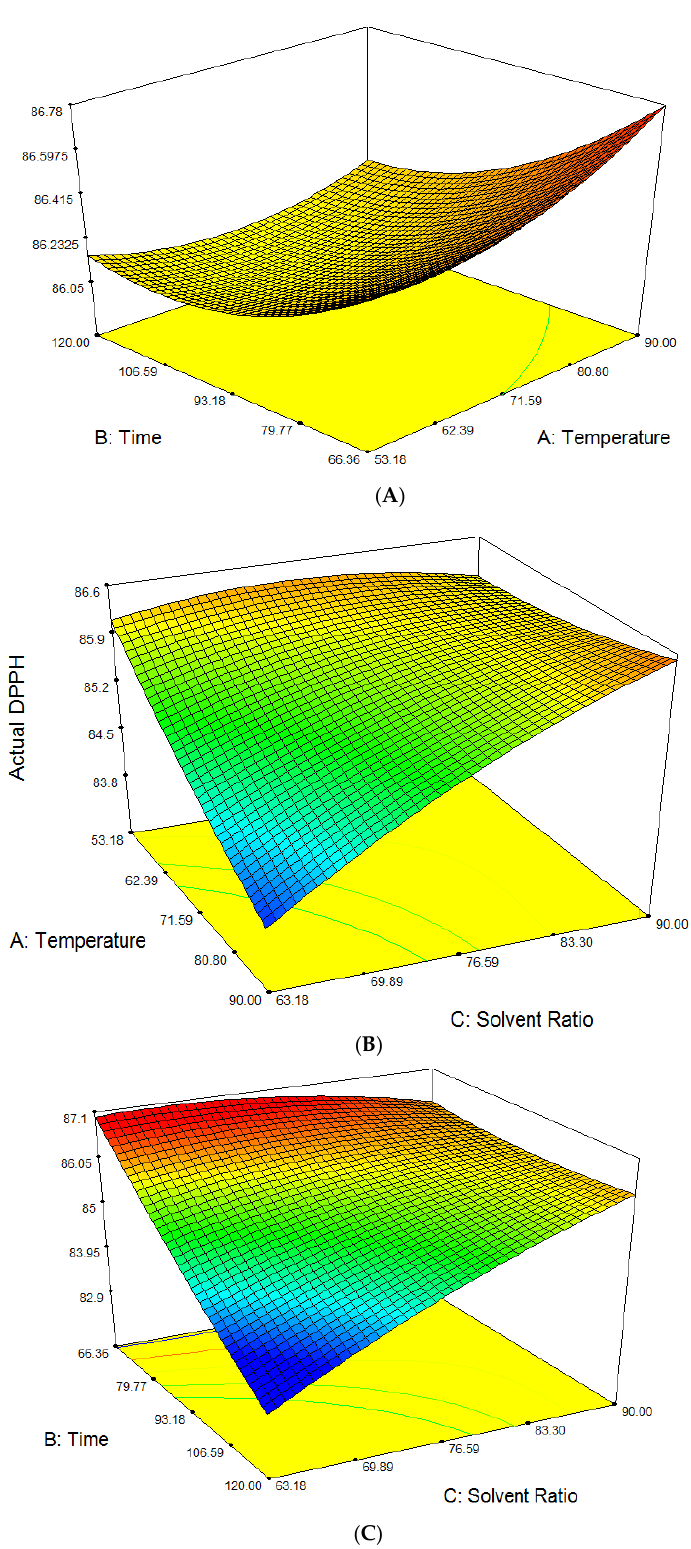
Figure 2. Response surface analysis (3D) on the effect of extraction temperature, ethanol concentration and extraction time on DPPH of P. macrocarpa fruit extract. ( A ) DPPH Scavenging Activity (%); ( B ) DPPH Scavenging Activity (%); ( C ) DPPH Scavenging Activity (%).